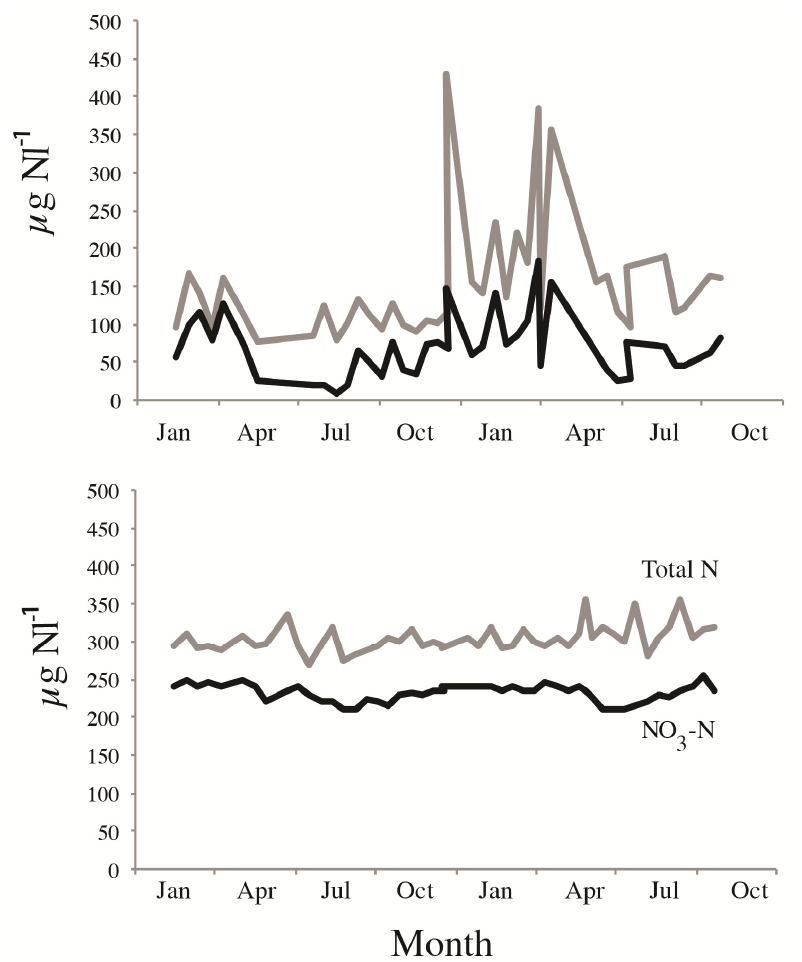
Figure 2. Example of seasonal responses and differences in total nitrogen (grey line) and NO -N (black line) in two adjacent catchments receiving almost equal amounts of 3 atmospheric DIN, but where the ( upper ) is a forested catchment, the ( lower ) a heathland catchments (see [15,25] for